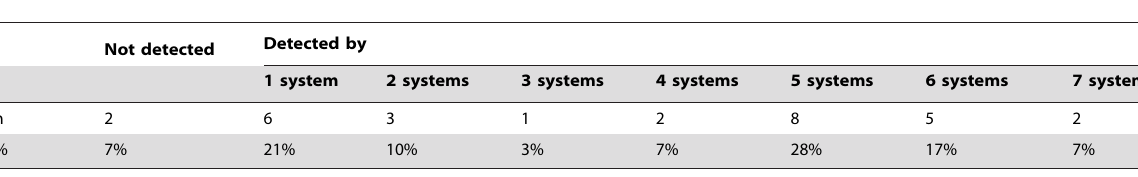
Table 4. Number of gold standard events detected by the systems.